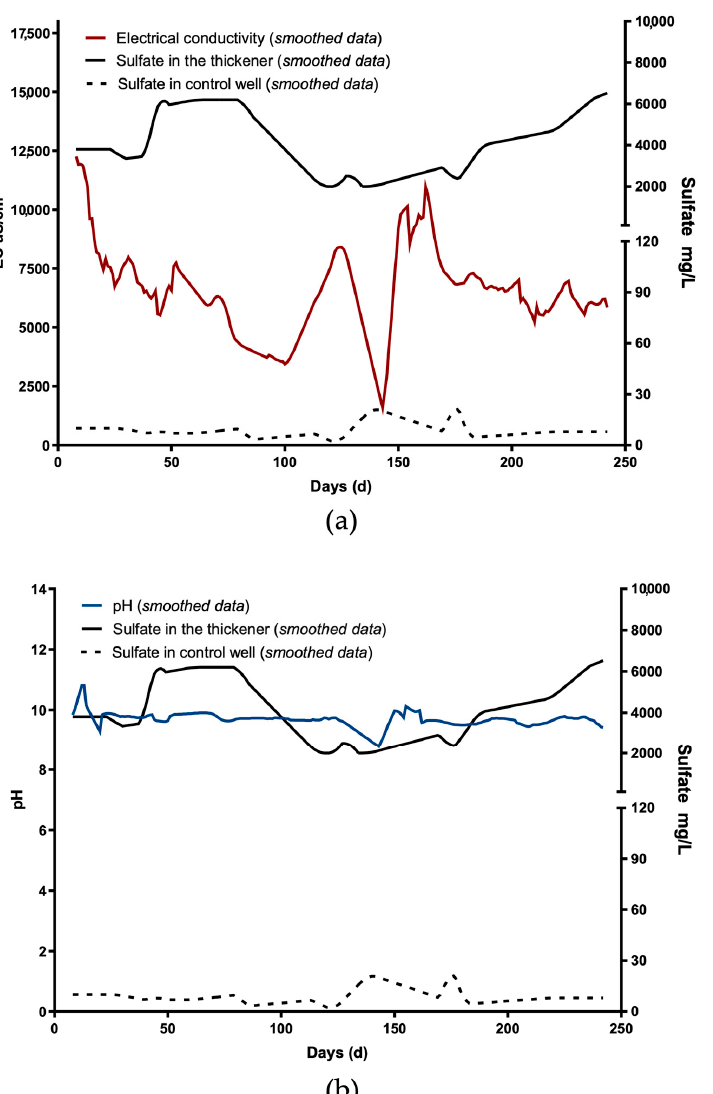
Figure 8. Time-series of smoothed electrical conductivity data ( a ) and pH data ( b ) of the thickener and relationship to the smoothed sulfate concentrations of the thickener and the control well. The pH and EC time series were smoothed using a 168-point moving average corresponding to a 7-day